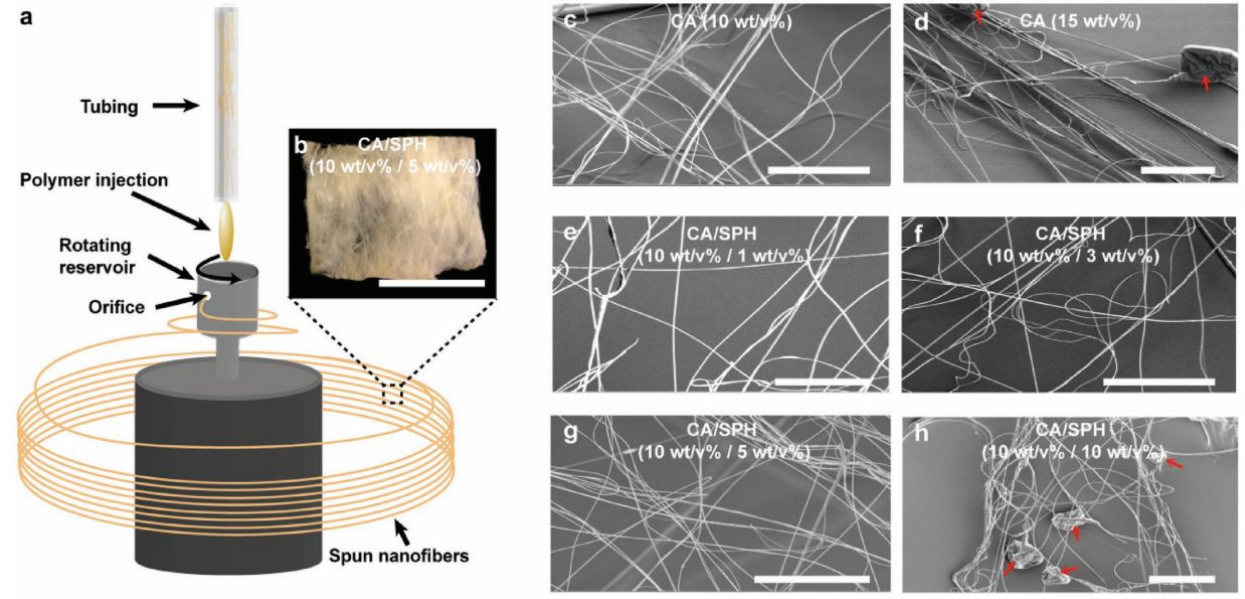
Figure 15. Scheme or rotary jet spinning ( a ); resulting cellulose acetate spun membrane ( b ); different morphology observed by SEM of fibers with various concentrations of CA and soy protein SPH ( c – h ) (reprinted from Advanced Healthcare Materials , 2018 , 7 , 1–13, Ahn, S.; Chantre, C.O.; Gannon, A.R.; Lind, J.U.; Campbell, P.H.; Grevesse, T.; O’Connor, B.B.; Parker, K.K. Soy Protein/Cellulose Nanofiber Scaffolds Mimicking Skin Extracellular Matrix for Enhanced Wound Healing, with permission from John Wiley & Sons,